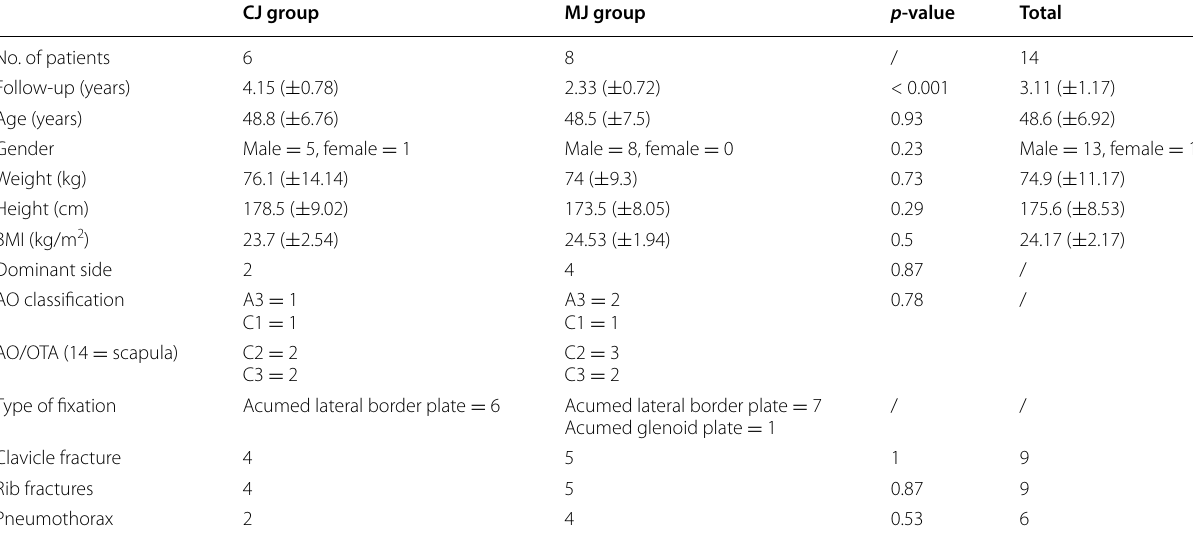
Table 1 Baseline characteristics: demographic and fracture data CJ group MJ